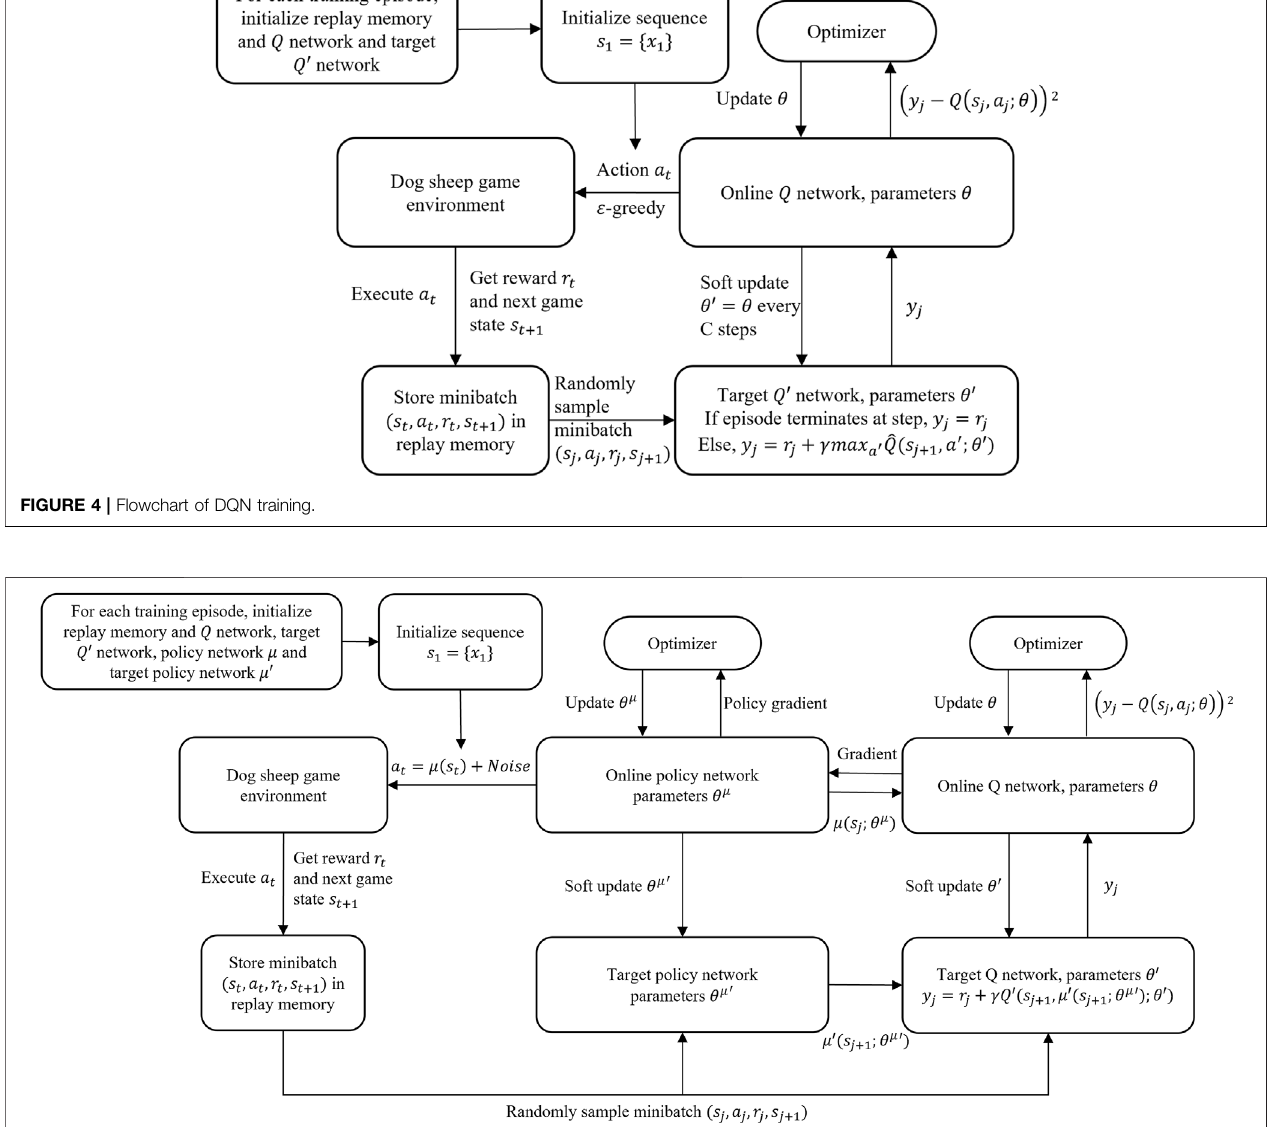
FIGURE 5 | Flowchart of DDPG